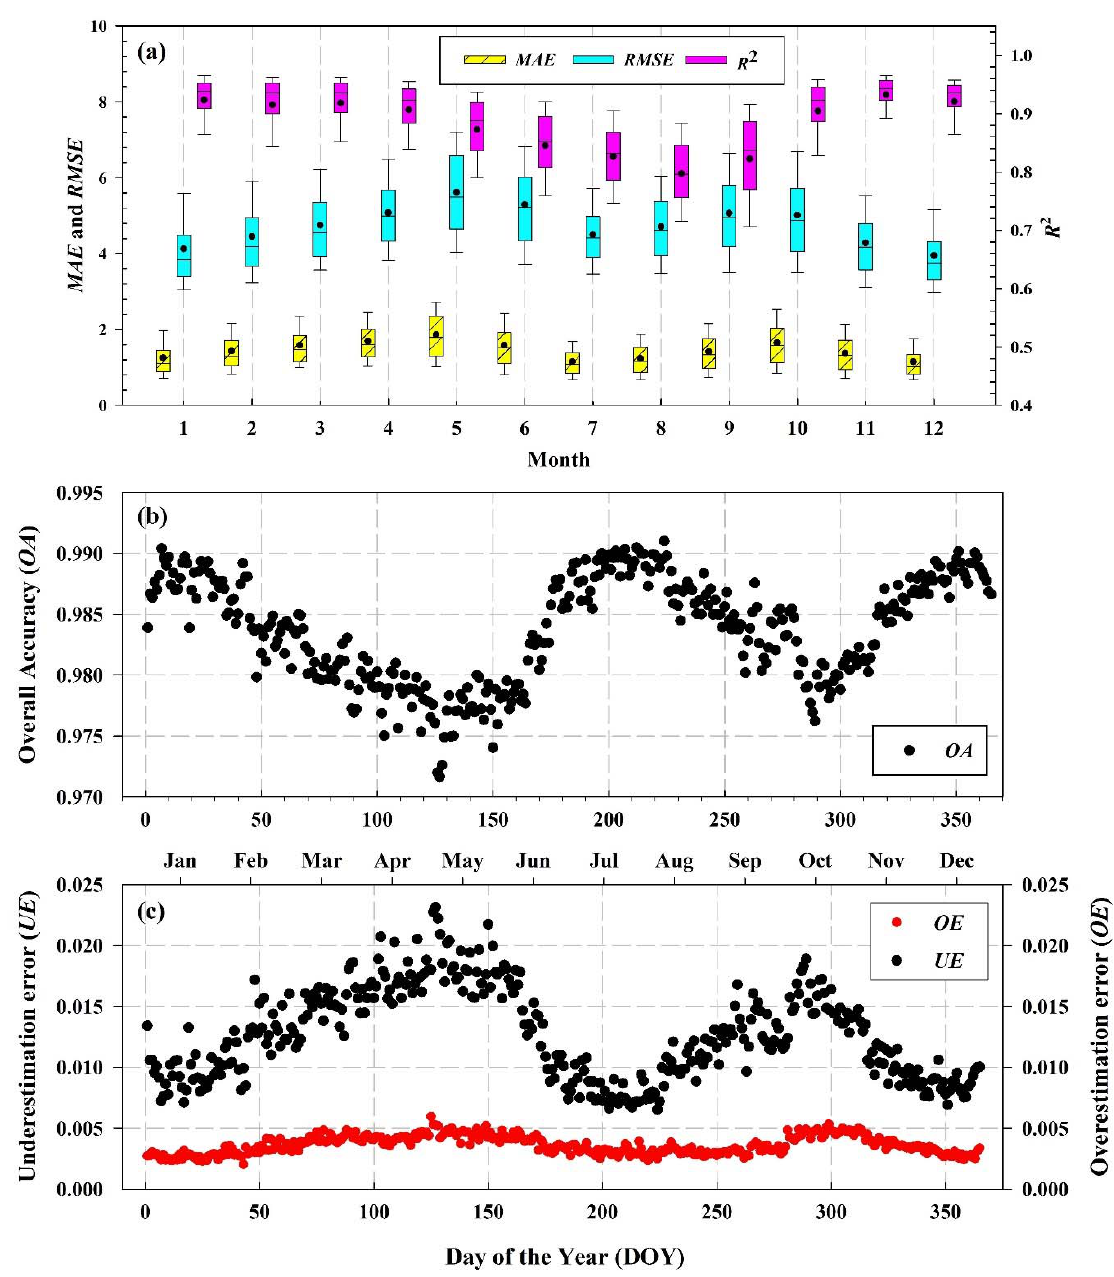
Figure 14. Performance metrics for NDSI and the classification accuracy of the 3DTF. ( a ) Box plot of MAE (yellow), RMSE (blue), and R 2 (pink) for the 3DTF algorithm. The top and bottom of each box are the 75th and 25th percentiles, respectively. The whiskers show the 5th (bottom) and 95th (top) percentiles. The horizontal line inside each box represents the median while the dot inside each box is the mean. ( b ) Scatterplot of the overall accuracy ( OA ) for the 3DTF algorithm. ( c ) Scatterplot of the underestimation error ( UE , black dot) and overestimation error ( OE , red dot) for the 3DTF algorithm.